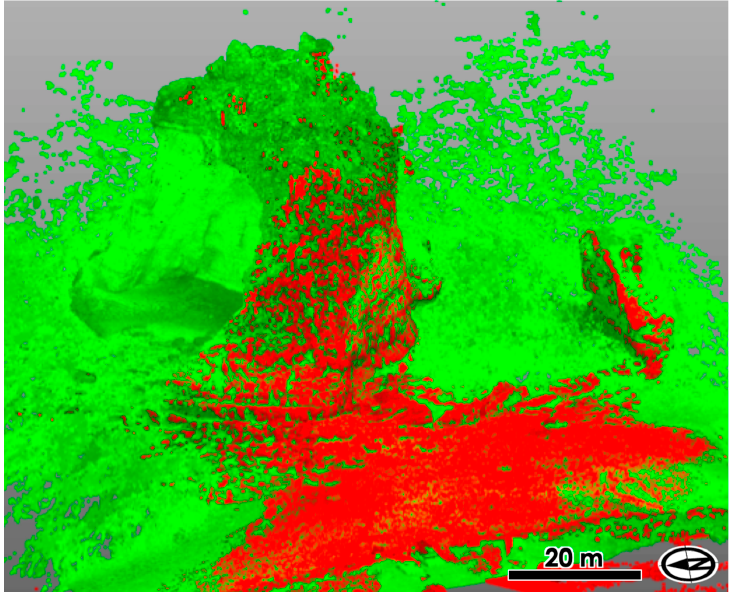
Figure 3. Aligned point clouds by TLS and UAS. Red points indicate those taken by TLS, whereas green points are those by UAS-SfM. The TLS-derived point cloud is only available for the land side. The UAS-derived point cloud contains erroneous points by moving sea water, which were removed after the alignment.